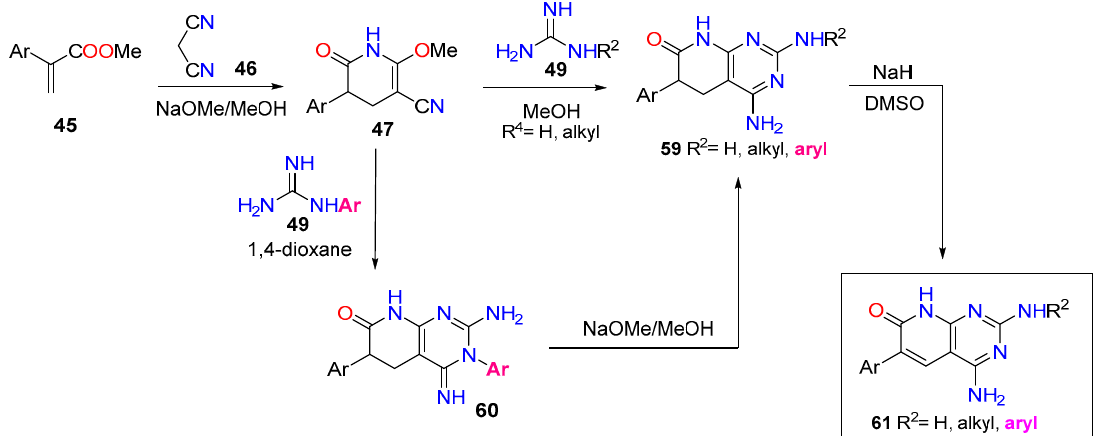
Figure 18. Synthesis of 5,6-dihydropyrido[2,3- d ]pyrimidin-7-(8 H )-ones and pyrido[2,3- d ]pyrimidin-7-(8 H )-ones from α , β -unsaturated esters ( 45 ) .